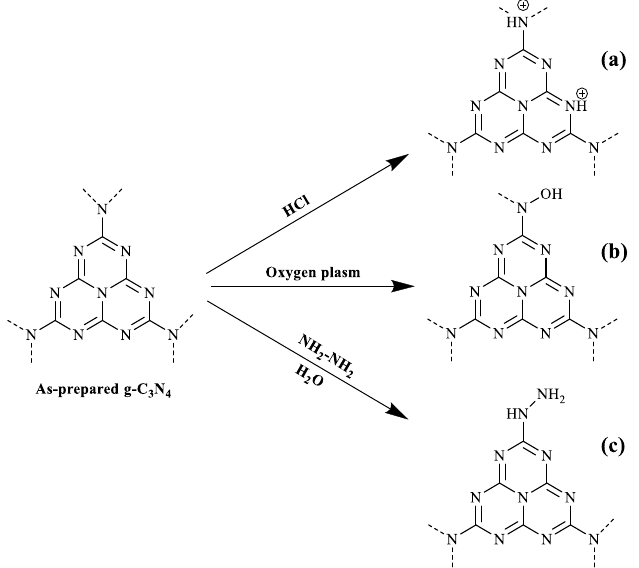
Figure 1. Scheme of the synthesis of: ( a ) protonated g-C 3 N 4 ; ( b ) oxygen plasm treatment used to introduce hydroxylamine structure (N-OH) on the surface of g-C 3 N 4 (hydroxylaminated g-C 3 N 4 ); and ( c ) hydrazinated g-C 3 N 4 .